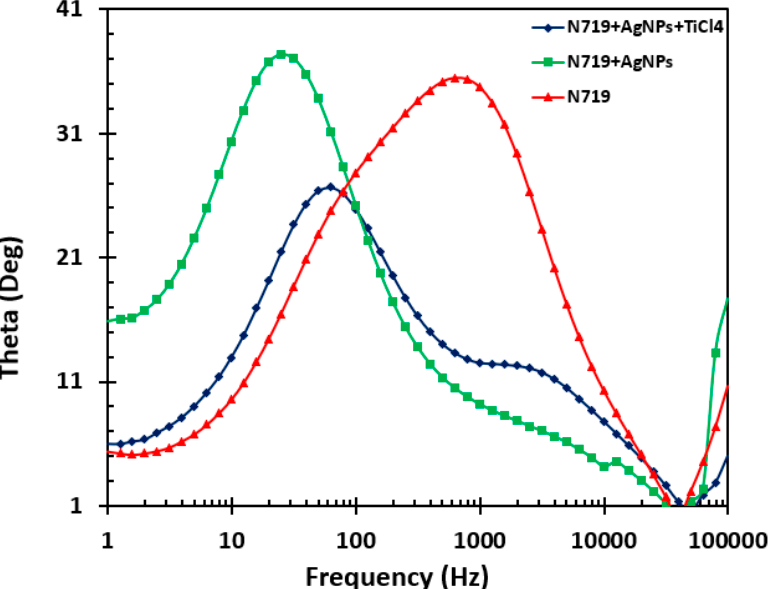
Figure 9. Bode plot of DSSCs fabricated with only N719, N719 with AgNPs treatment, and N719 with AgNPs and TiCl 4 treatment.